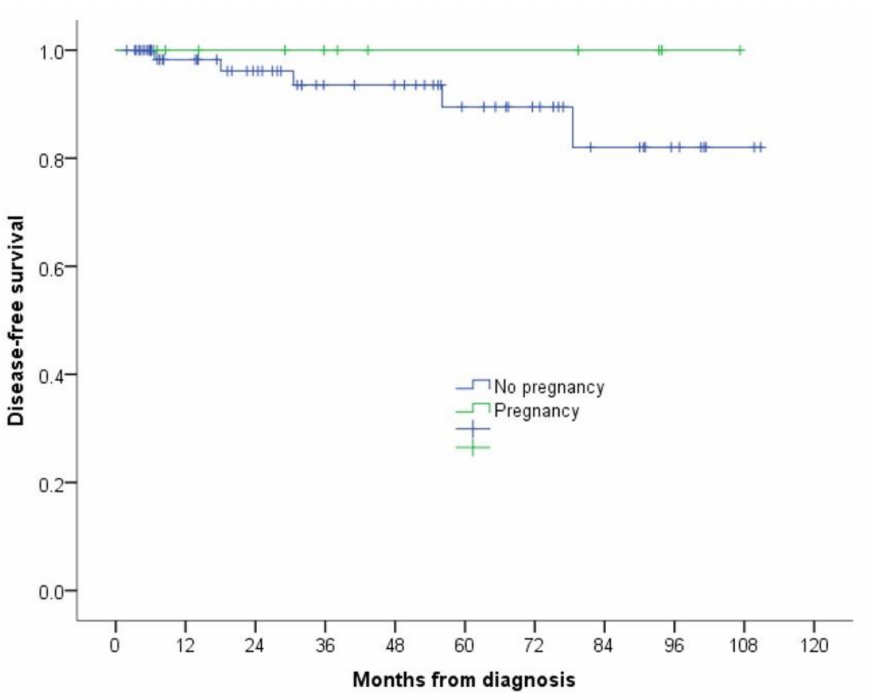
Figure 3. Kaplan–Meier survival curve of pregnant vs. non-pregnant women after a diagnosis of